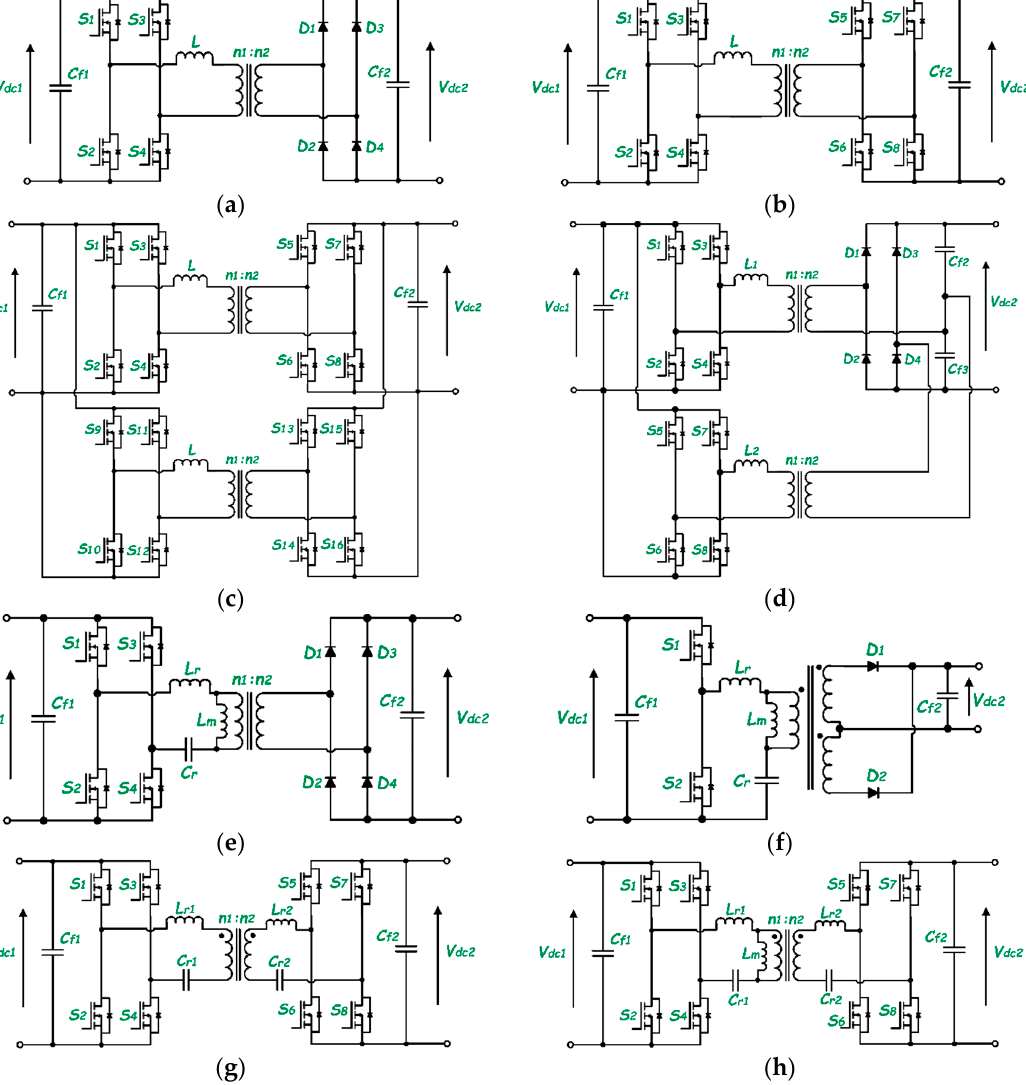
Figure 7. Isolated DC–DC converters: ( a ) phase shift full-bridge ZVS converter; ( b ) dual active bridge; ( c ) cascaded dual active bridge; ( d ) interleaved full-bridge with voltage doubler; ( e ) full- bridge isolated LLC resonant converter; ( f ) half-bridge LLC resonant converter; ( g ) full-bridge CLLC resonant converter; ( h ) full-bridge CLLLC resonant converter.